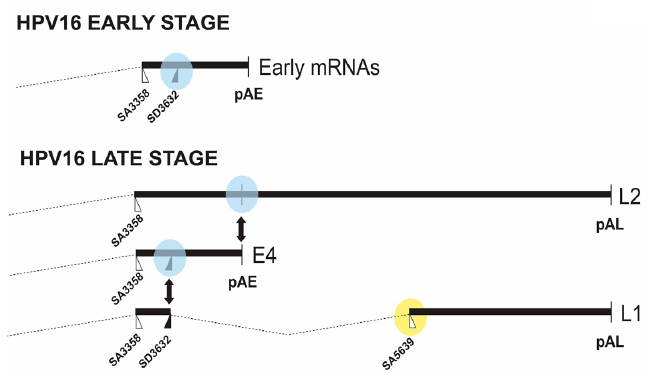
Figure 3. Schematic drawing of the middle and late regions of the HPV16 genome. Upper panel: splicing to HPV16 3 ′ -splice site SA3358 followed by polyadenylation at the HPV early polyadenylation signal pAE at the early stage of the HPV16 infection. The suppressed HPV16 late 5 ′ -splice site SD3632 is encircled [6]; Lower panel: at the late stage of the HPV16 infection the three late mRNAs L2, L1 and E4 co-exist. This is the result of partial inhibition of pAE, which causes read-through into the late region and polyadenylation at pAL to produce the L2 mRNAs. Activation of the two exclusively late splice sites SD3632 and SA5639 results in production of L1 mRNAs, while a fraction of the mRNAs that are polyadenylated at pAE produces E4 mRNAs. The E4 protein is produced at both early and late stages of the HPV16 life cycle. The regulated HPV16 late 5 ′ -splice site SD3632 and the early polyA signal pAE are encircled in blue and HPV16 late 3 ′ -splice site SA5639 in yellow.